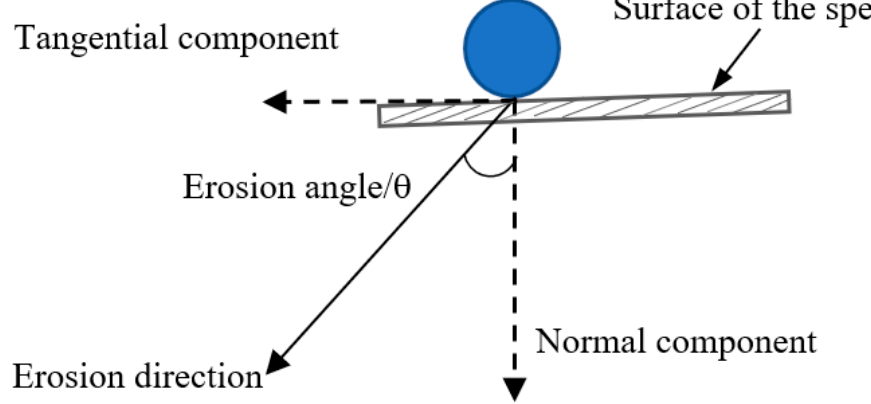
Figure 6. Contact diagram of particle and specimen surface.